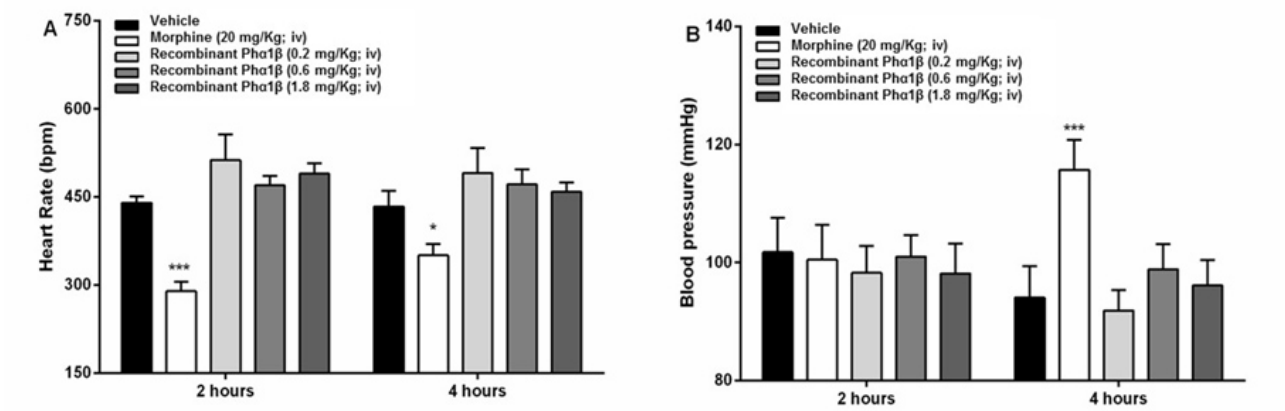
Figure 3. Effects of intravenous (i.v.) recombinant Phα1β administration on mouse cardiac function. (A) Heart rate and (B) blood pressure measured at 2 and 4 h after vehicle, morphine (20 mg/kg i.v.), or recombinant-Phα1β (0.2, 0.6, or 1.8 mg/ kg i.v.) treatment. The mean and SEM are represented by each bar and vertical line, respectively (5 groups with 6 mice per group, 30 mice in total). *p < 0.05 and ***p < 0.001 represent significant differences between Phα1β recombinant and PBS treatments, as analyzed by one-way analysis of variance followed by Dunnett’s post-hoc test (n= 4 to